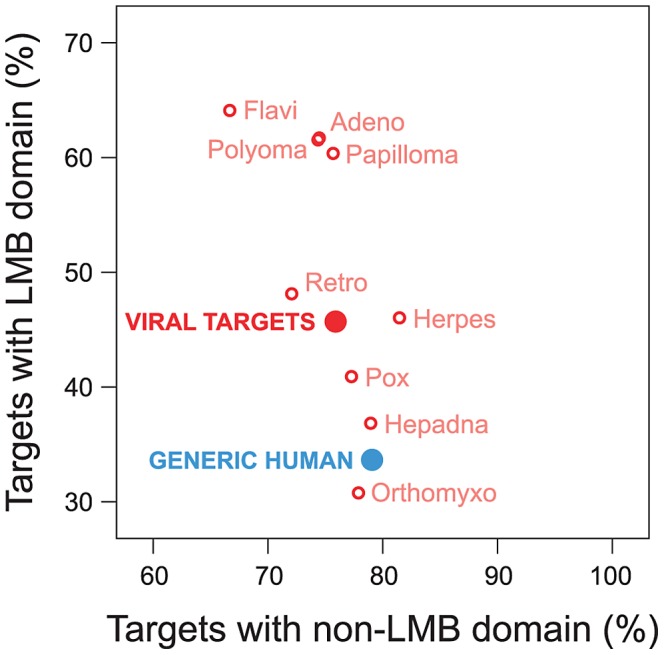
Viruses tend to target human proteins containing linear motif-binding (LMB) domains.We compared domain composition of generic human proteins in the endogenous network (blue) to human proteins targeted by viruses (“viral targets”, red). The vertical axis indicates the fraction of proteins in a group containing LMB domains; the horizontal axis indicates the fraction of proteins containing non-LMB domains. Relative to generic human proteins, human proteins targeted by viruses are significantly more likely to contain an LMB domain (vertical axis; Fisher's exact test, two-tailed P<10−15), and are slightly less likely to contain non-LMB domains (horizontal axis; P = 0.012).